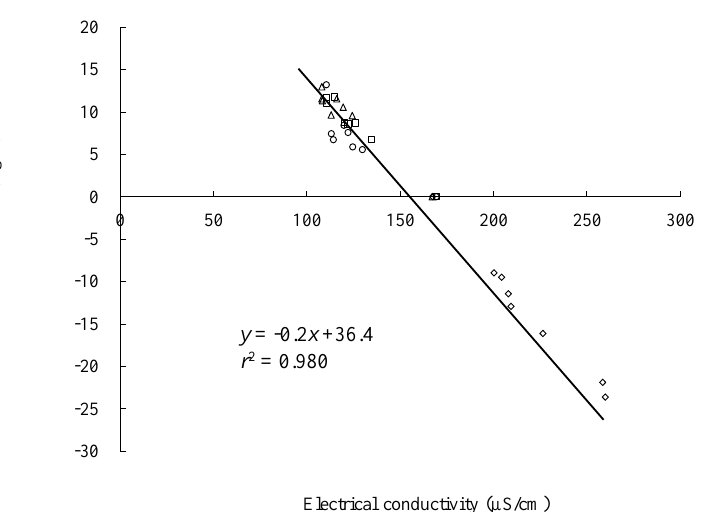
Figure 5. Relationship between total removed ions and electrical conductivity. ◇ RB, □ 5-SN, △ 5- NP, ○ 5-PS.